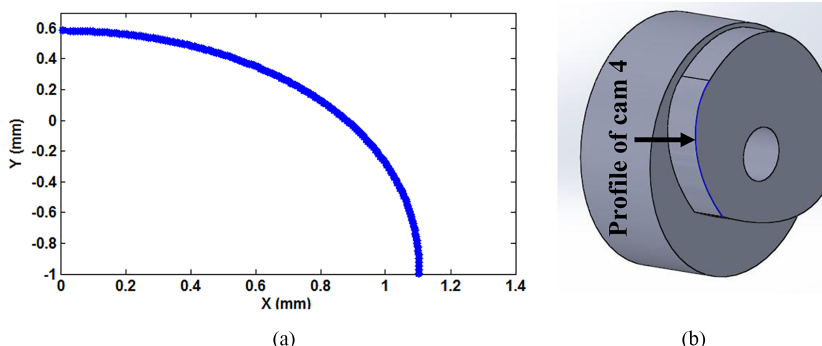
Figure 6. Cam on DIP joint (a) cam 4 profile (b) CAD drawing.